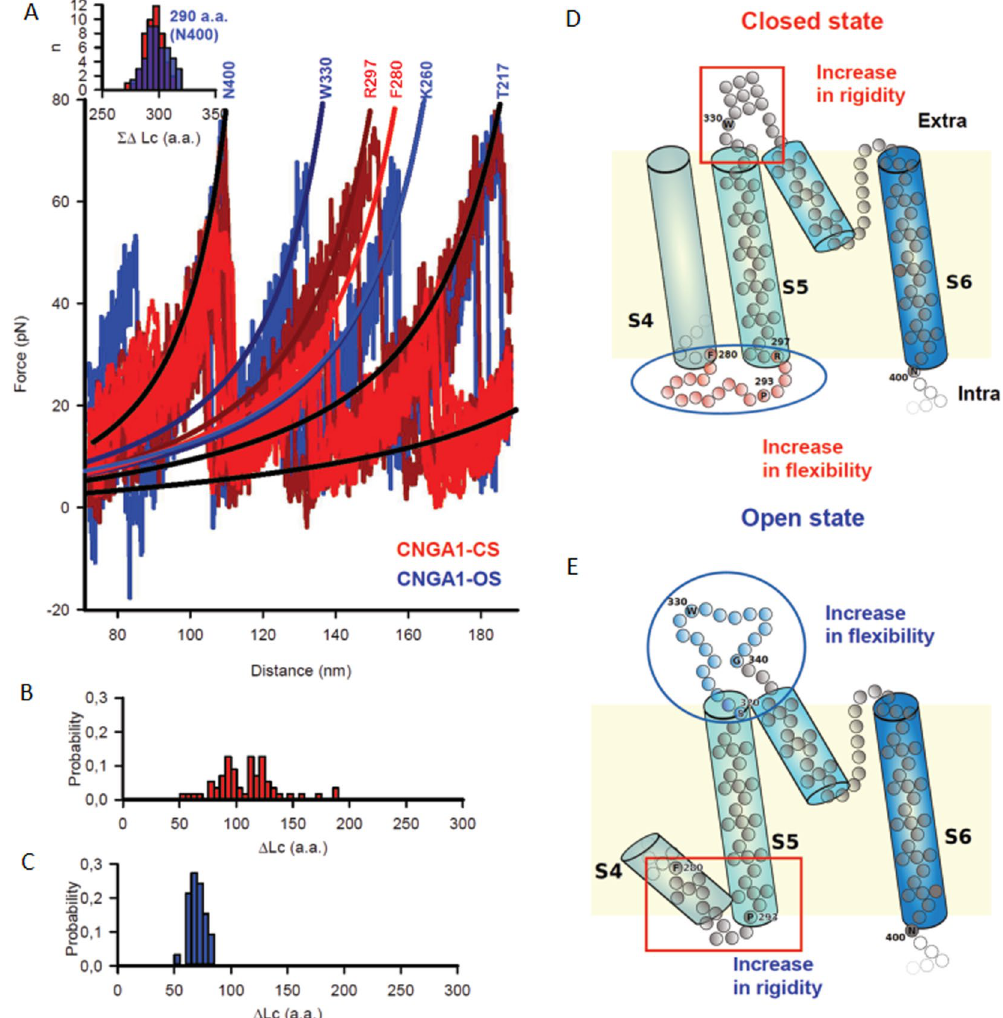
Figure 3. Flexibility in the loops between S4-S5 and S5-P-Helix during CNGA1 channels gating. ( A ) Superposition of F-D curves from unfolding of CNGA1 in the closed (n = 10) (CNGA1-CS, light and dark red) and open (n = 10) (CNGA1-OS, blue) states. The solid line represents the WLC fitting to the corresponding unfolded peaks, and the numbers represents the approximate peak position in the a.a. chain. Inset represents the ∑ ∆ Lc histogram for the peak at N400 (290 a.a.), implying a conserved unfolding step for both open and closed states. ( B ) Distribution of unfolded length for the domains S6–S5 for CNGA1-CS (n = 110). ( C ) As in ( B ) but for CNGA1-OS (n = 71). ( D – E ) Cartoon representation of the S5-S6 domains, showing the change in flexibility between the intracellular and extracellular loops of S5 for closed and open state,